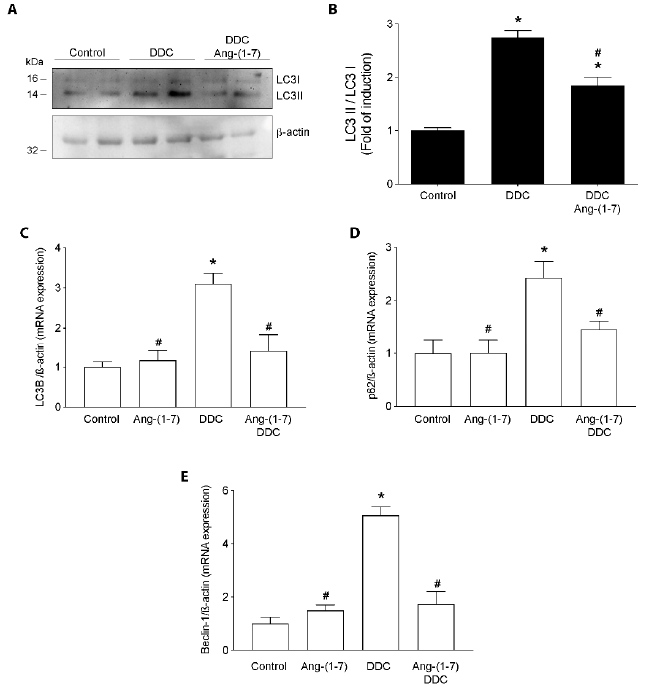
Figure 7. Ang- (1-7) prevents the increment of autophagy in gastrocnemius from DDC-treated mice. C57BL/6J male mice were fed a standard diet (Control) or DDC-supplemented diet (DDC) with or without Ang-(1-7) (through osmotic minipumps). Five animals per group were used for three independent experiments. When the experiment finished (week 6), the gastrocnemius muscle was removed, and RNA and protein extraction were performed. ( A ) LC3 I and LC3 II protein levels were evaluated by western blot. β -actin was used as the loading control. Molecular weights are depicted in kilodaltons. ( B ) Densitometric analysis of the band was performed, and the ratio of LC3 II/LC3 I is shown. Values are expressed as fold of induction relative to control and represent the mean ± SEM. RT-qPCR determined LC3B ( C ), p62 ( D ), and Beclin-1 ( E ) gene expression. β -actin was used as a housekeeping gene (qPCR). Values represent the mean ± SEM. (For B, C, D and E: (* p < 0.05 vs. Control, # p < vs. DDC. One-way ANOVA, Tukey’s multiple comparisons test).